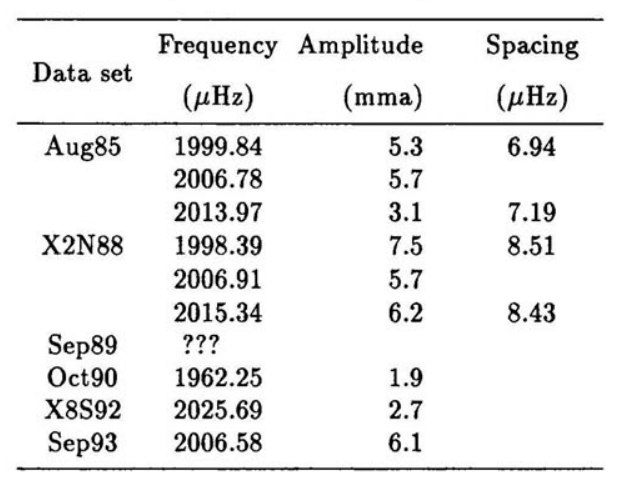
Table 2. Identified power in the 500 s region of G 29-38's FTs.